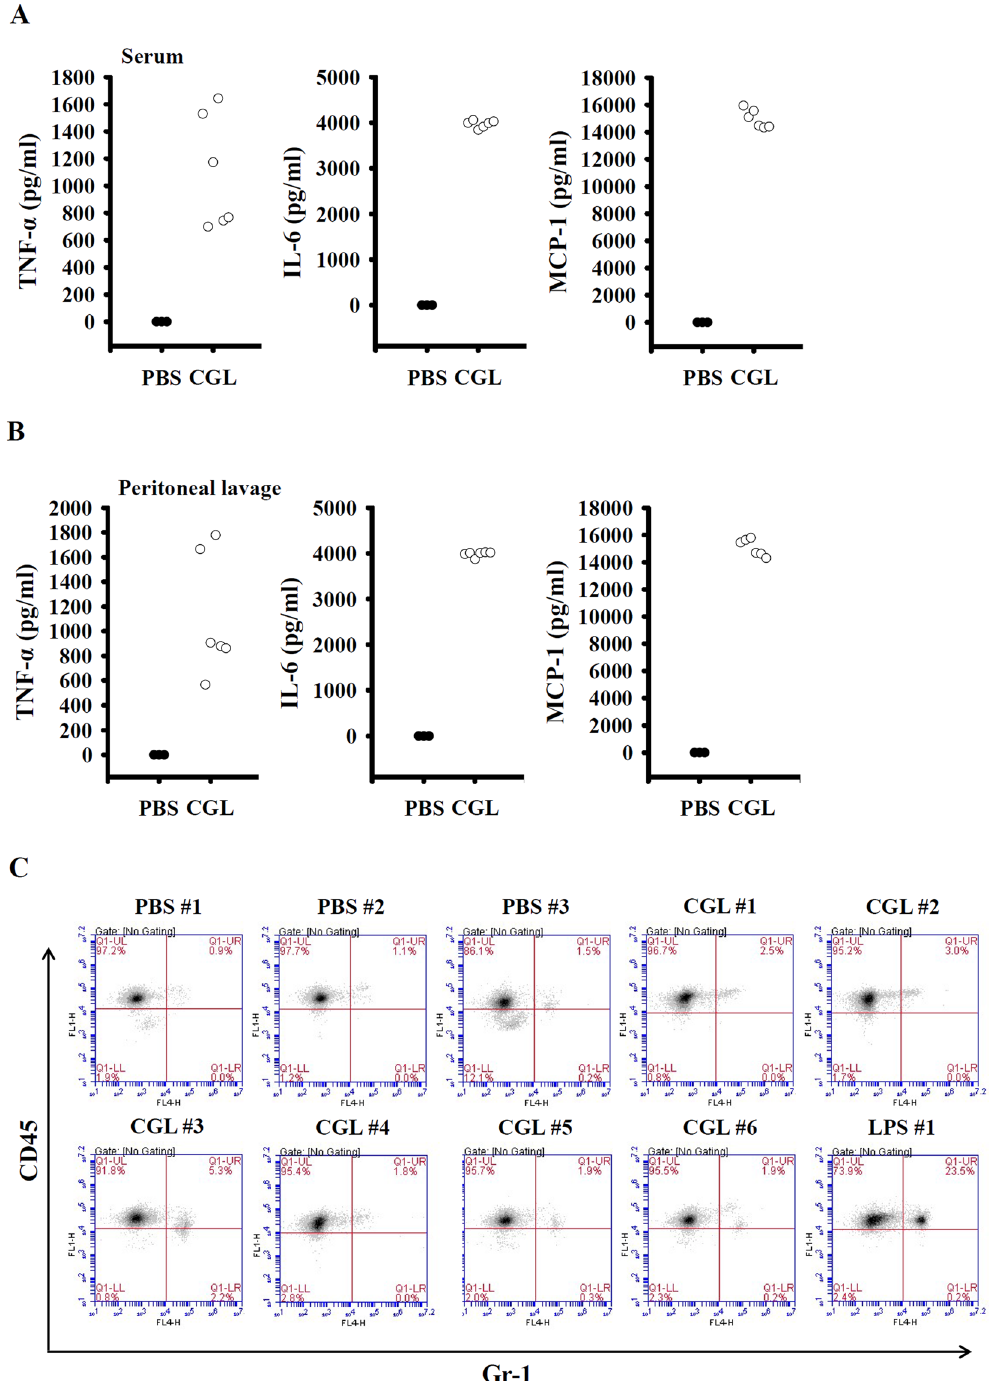
Figure 9. CGL induces cytokine expression in vivo . Mice were intraperitoneally injected with CGL (20 mg/kg), LPS (10 mg/kg) or PBS for 4 h. The levels of TNF- α , IL-6 and MCP-1 in serum ( A ) and peritoneal lavage ( B ) were measured by ELISA. The levels of peritoneal neutrophils infiltration were measured by flow cytometry ( C